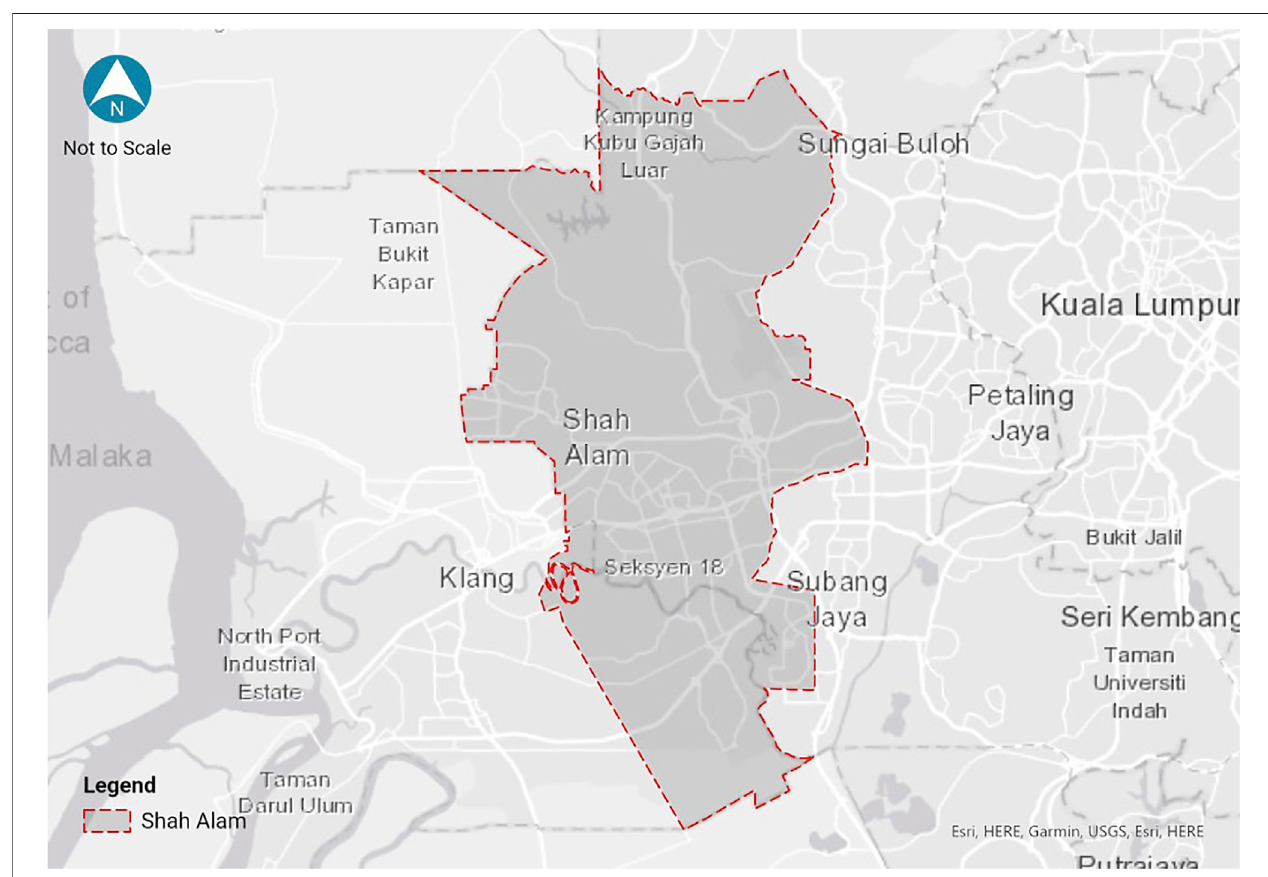
FIGURE 2 | Map of Shah Alam (Source: ESRI, 2021). Map Figure is from ArcGIS Online map hosted by Esri. We would like to assure the images is retrieved from ESRI free platform and we have go through the disclaimer and noti fi cation details at https://doc.arcgis.com/en/arcgis-online/reference/display-copyrights.htm.